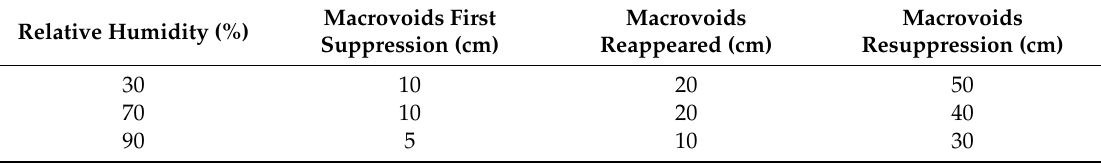
Table 7. Relationship between macrovoids and air gap under di ff erent relative humidity [202]. Macrovoids First Macrovoids Relative Humidity (%) Suppression (cm) Reappeared (cm)